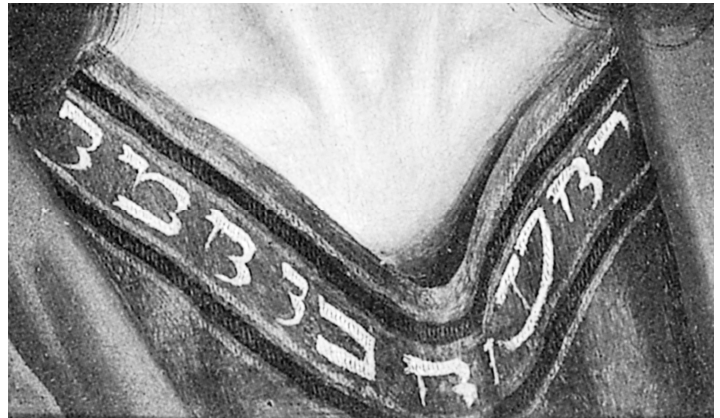
Figure 8. Quentin Massys? Bust of Christ (detail), before 1529? The Hague, RKD Netherlands Institute for Art History. Courtesy of the RKD Netherlands Institute for Art History.